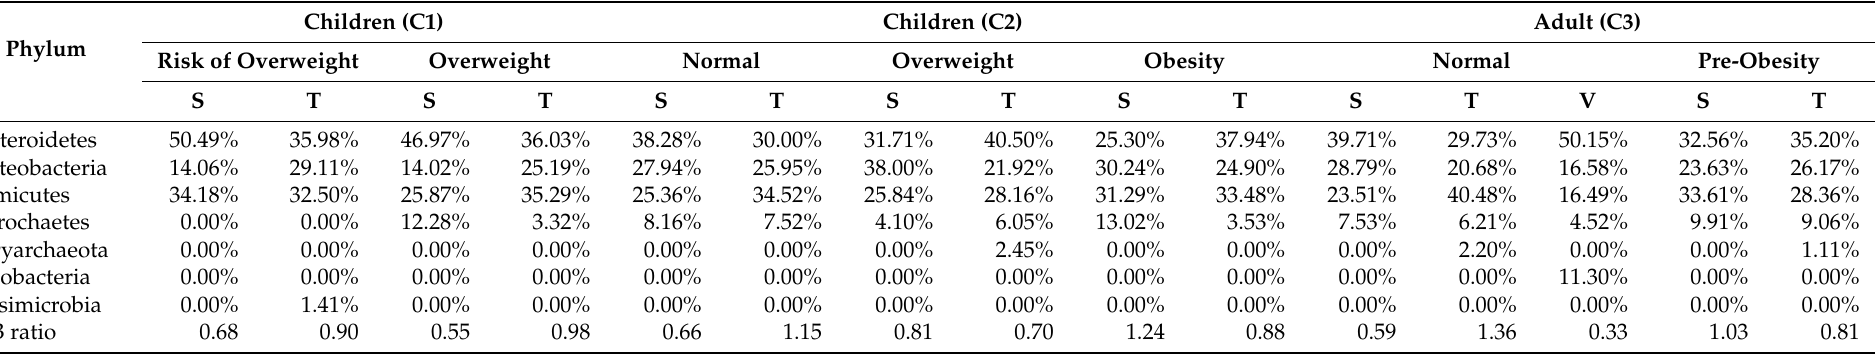
Table A10. Phylum distribution (relative abundances) for the BMI and age groups for the three locations: Siminke (S), Tezhumake (T), and Valledupar (V). Valledupar data were only available for adults with normal BMI